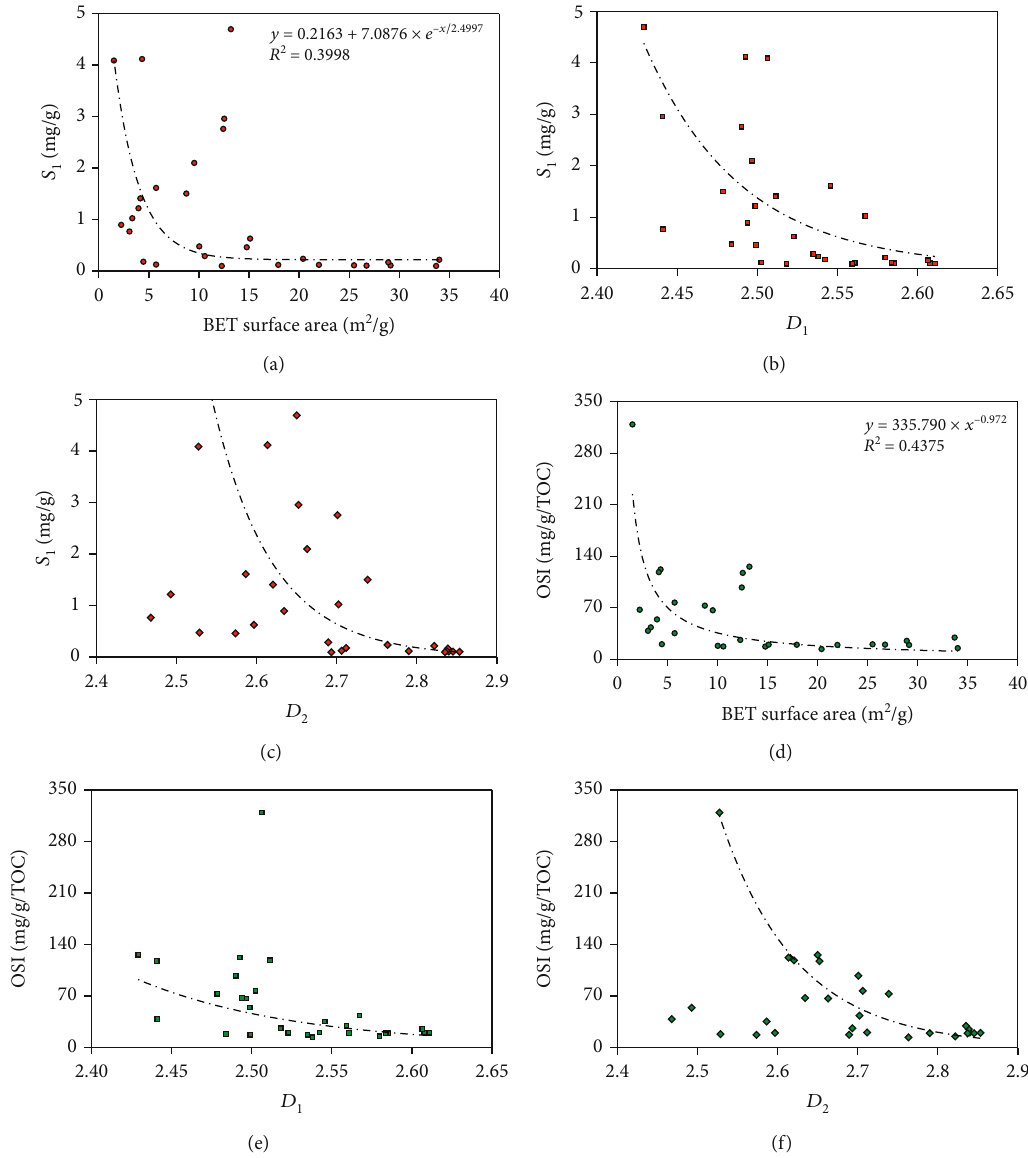
Figure 12: Relationships between oil content ( S